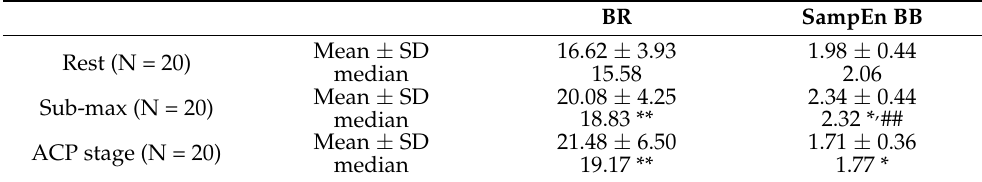
Table 4. BR and SampEn BB during the rest, sub-max, and ACP